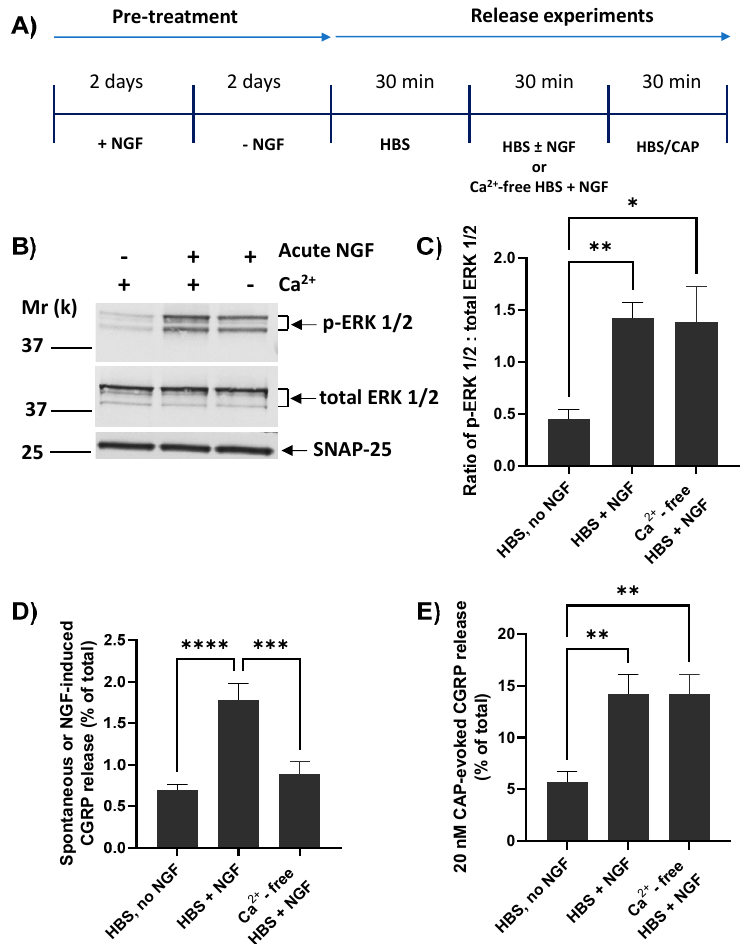
Figure 4. Extracellular Ca 2+ is required for NGF to raise CGRP release but not for its enhancement of CAP-evoked Ca 2+ -dependent exocytosis. ( A ) NGF-starved TGNs were exposed in sequence for three 30 min. periods as follows. In the first period, all cells were exposed to HBS only. For period 2, the cells were split into three cohorts and incubated with Ca 2+ /HBS modified as follows: Cohort 1, HBS only; Cohort 2, Ca 2+ /HBS containing 100 ng/mL NGF; Cohort 3, HBS containing 100 ng/mL NGF but with Ca 2+ replaced by 2 mM EGTA. In period 3, all cells were incubated with Ca 2+ /HBS containing 20 nM CAP. ( B ) In a separate set of experiments, TGNs were processed as far as period 2 before being lysed in 1x LDS buffer, and the ERK phosphorylation was determined by Western blotting as detailed in the Materials and Methods. ( C ) Histogram showing the ratio of signal intensity for p-ERK 1/2 to total ERK 1/2 (mean + s.e.m., n ≥ 3, N = 2), determined from the requisite immuno-reactive bands detailed in panel B. ( D ) Spontaneous or NGF-induced CGRP release during incubation period 2 and ( E ) 20 nM CAP-evoked CGRP release in period 3 calculated by subtracting the amount released during incubation 1, both expressed as a % of total CGRP content; n = 9, N = 3. For all histograms, one-way ANOVA was used followed by Bonferroni’s post hoc test, and significance indicated with asterisks; * p < 0.05, ** p < 0.01, *** p < 0.001, **** p < 0.0001. Each column and associated error bar represents mean + s.e.m., respectively.